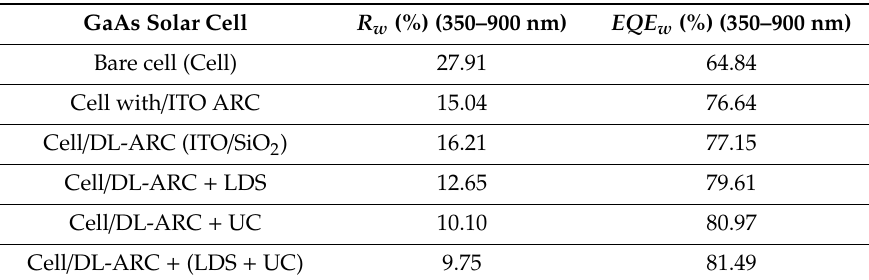
Figure 8. EQE response of bare-type GaAs single-junction solar cells and GaAs solar cells coated with layer of ITO or ITO/SiO 2 . Table 1. R w and EQE w of all evaluated cells. Table 1. R w and EQE w of all evaluated cells.